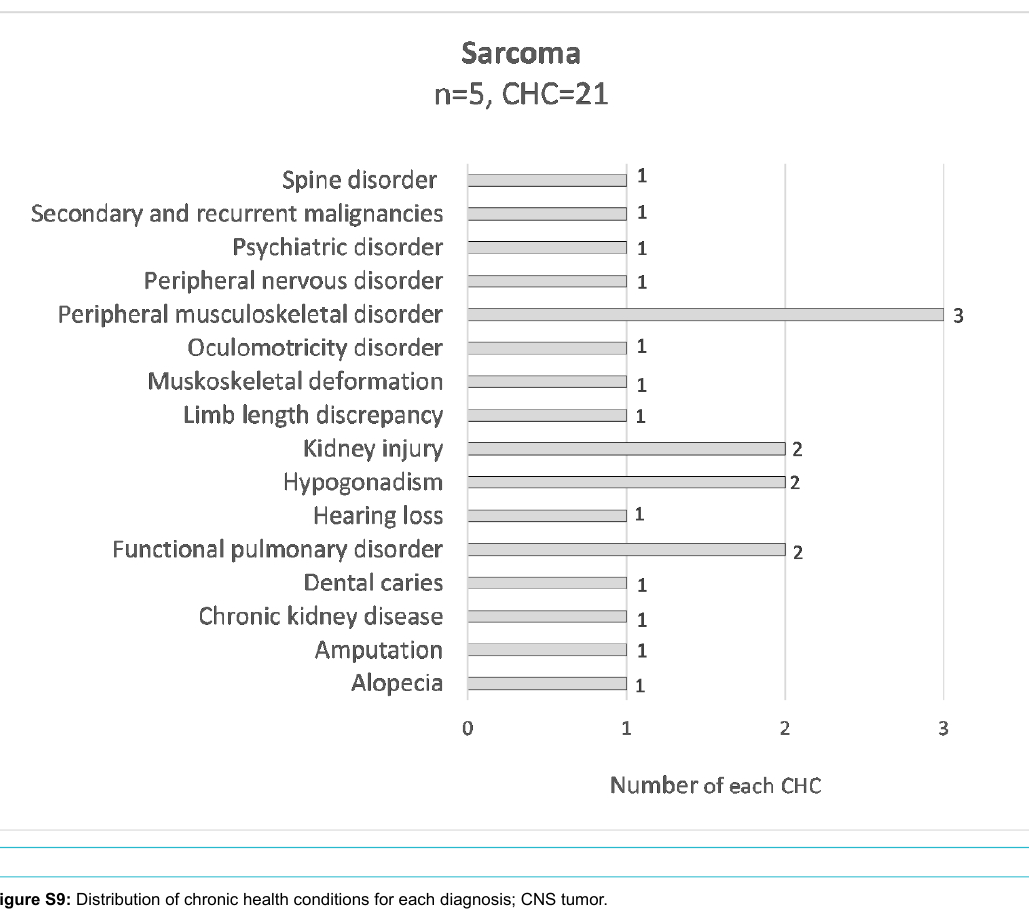
Figure S8: Distribution of chronic health conditions for each diagnosis; sarcoma.